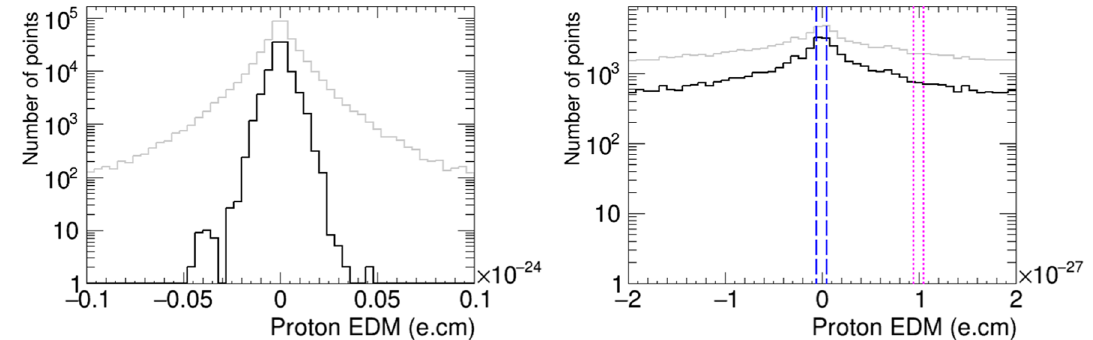
Fig. 3 Distributions of the proton EDM, showing the effects of tak- ing into account the LHC constraints on sparticle masses and imposing the current EDM constraints. Gray histograms: all points passing LHC mass and flavour constraints; black: including current EDM limits. The